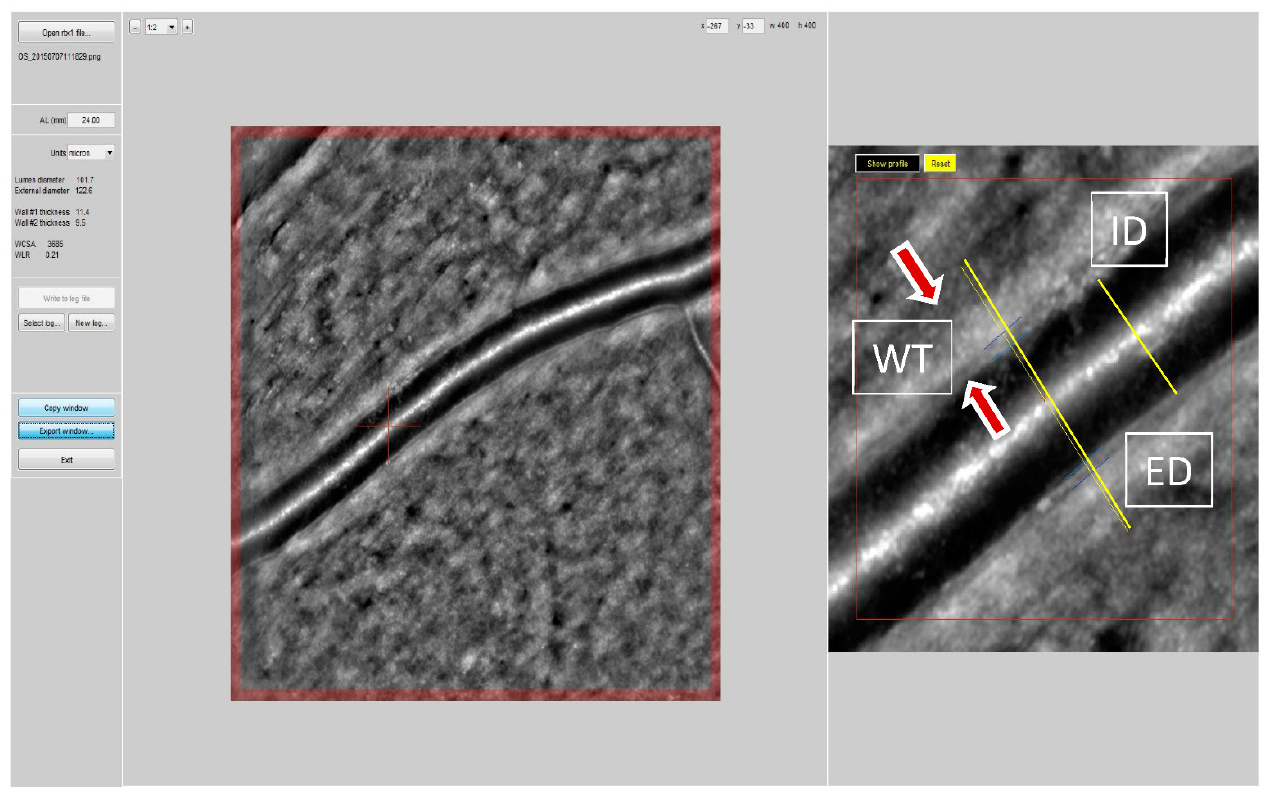
Figure 1. An example of retinal arteriole’s lumen and wall thickness measurement. ID internal diameter; ED external diameter; WT wall thickness.